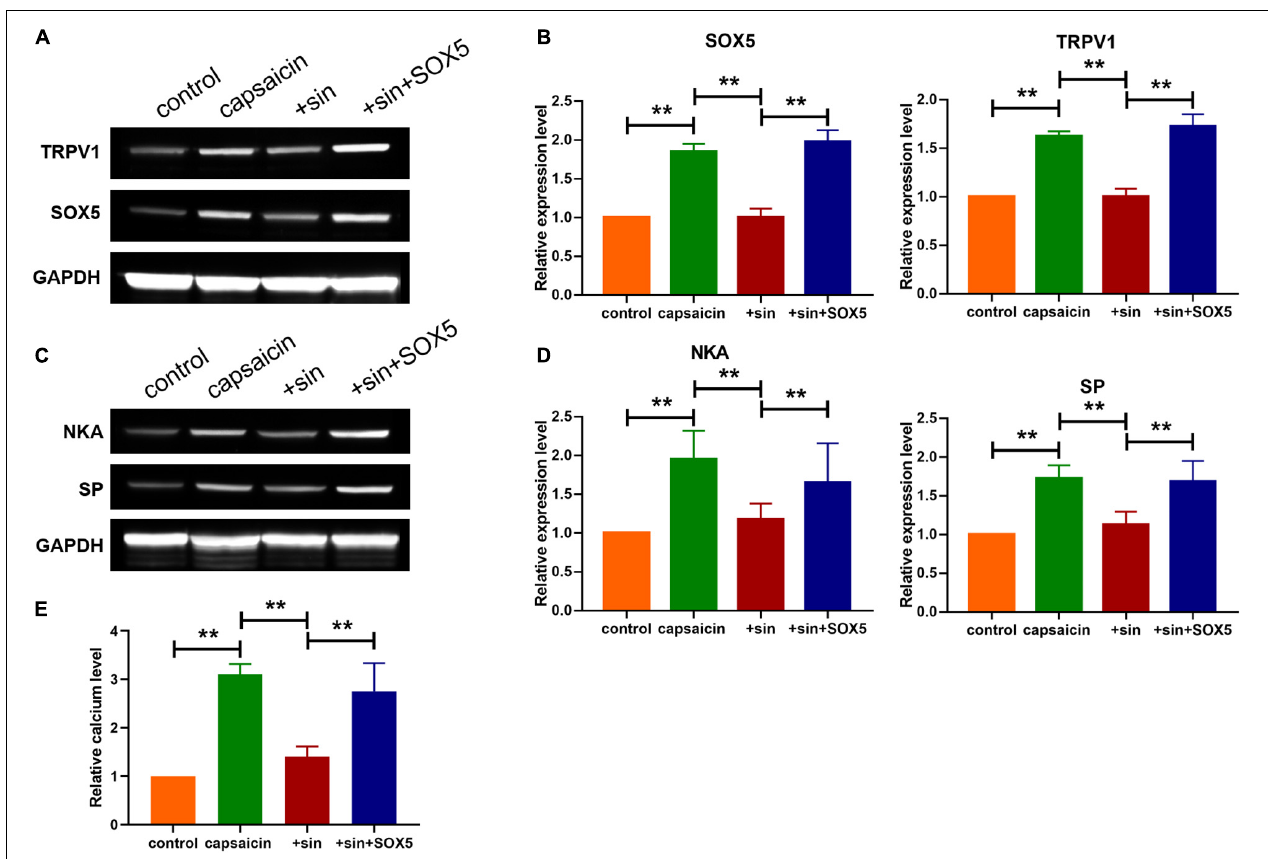
FIGURE 5 | Sinomenine reduced the protein level of TRPV1 via downregulating SOX5 expression in neuronal cells. (A,B) Effect of sinomenine treatment and SOX5 administration on the protein expression levels of TRPV1 and SOX5 in neuronal cells. Data are mean ± SEM; one-way ANOVA was used for statistical analysis. (C,D) Effect of sinomenine treatment and SOX5 administration on the protein levels of SP and NKA in neuronal cells. Data are mean ± SEM; one-way ANOVA was used for statistical analysis. (E) Intracellular calcium levels in neuronal cells. Data are mean ± SEM; one-way ANOVA was used for statistical analysis. ** P < 0.01; n =